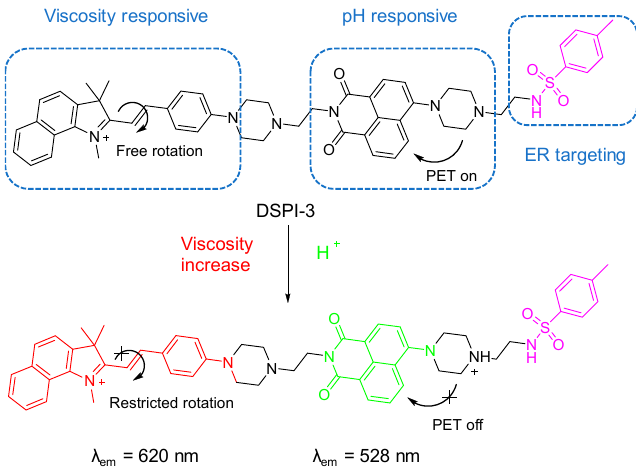
Figure 20. Response mechanism of DSPI − 3 to viscosity and pH [82].